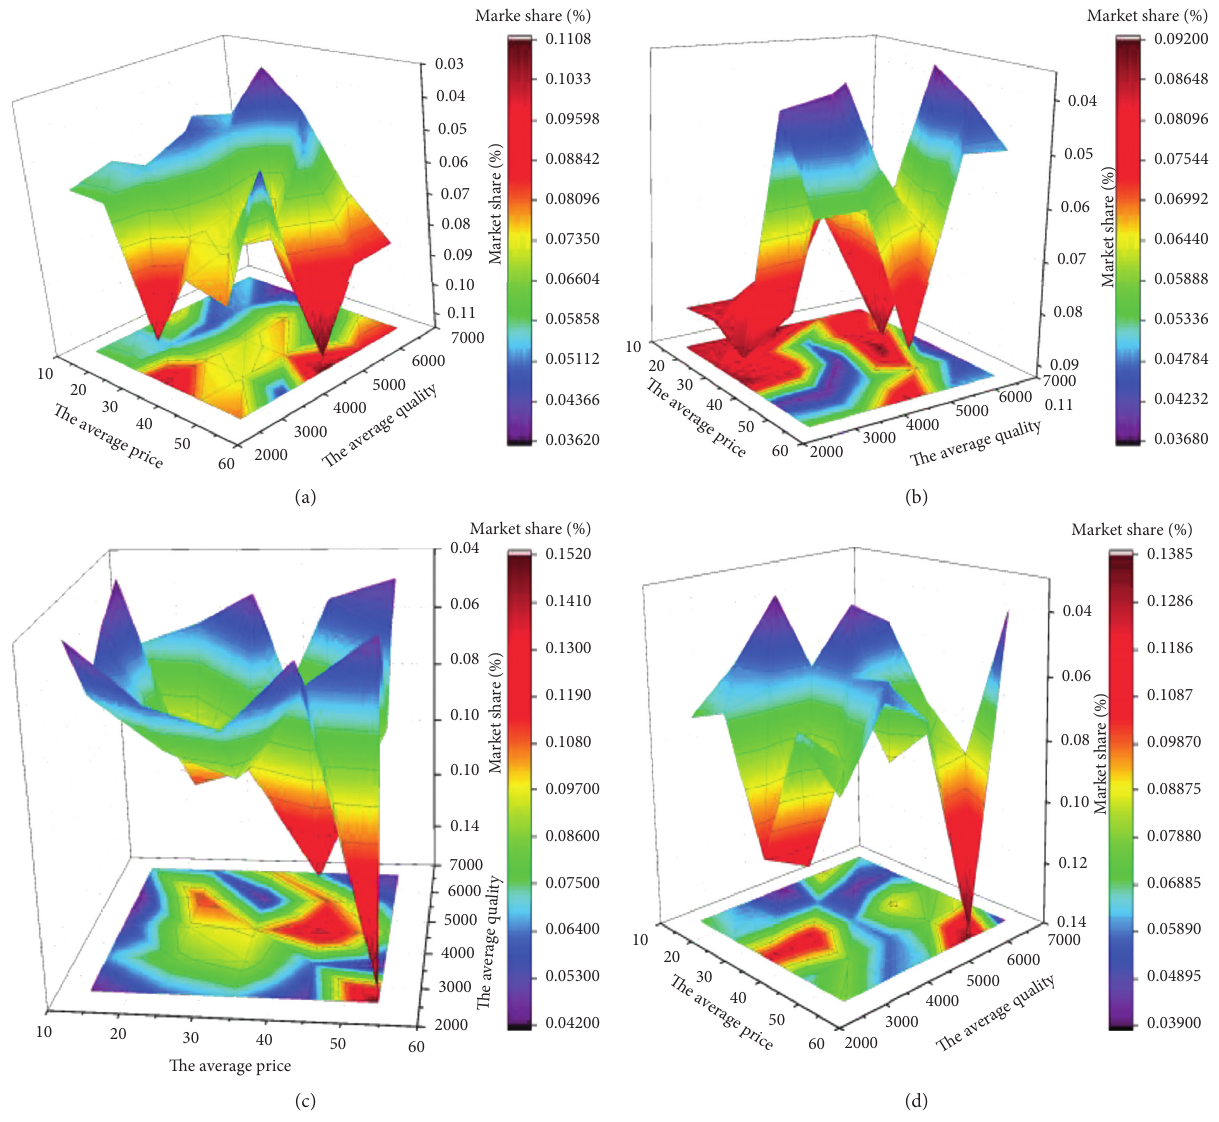
Figure 11: Influence of average quality and price on market share based on different network topologies.